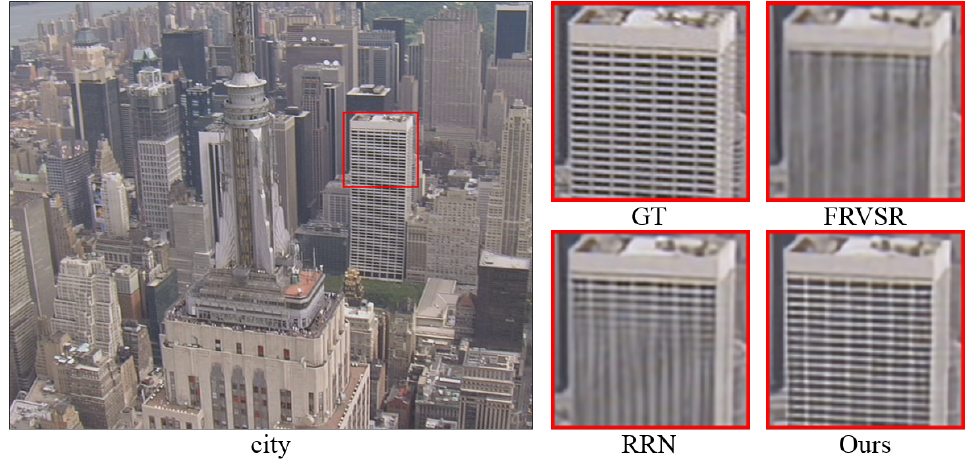
Figure 1. Comparison of the × 4 reconstruction results of our method and other methods in city video